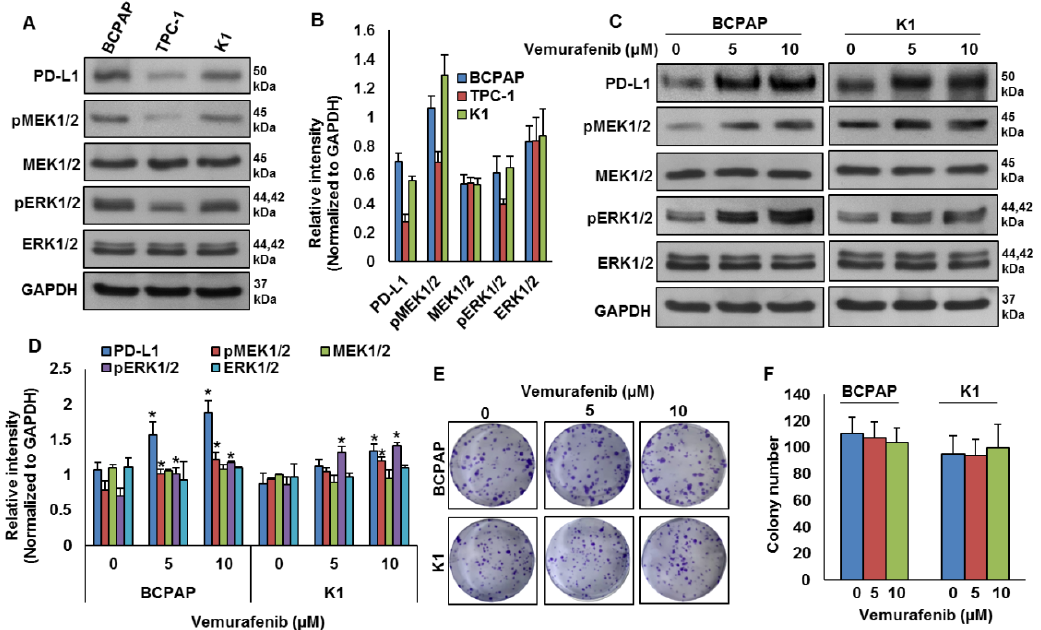
Figure 3. BRAF mutation and its association with PD-L1 in PTC in vitro. ( A , B ) Basal expression of PD-L1 in PTC cell lines. Proteins were isolated from three PTC cell lines and immuno-blotted with antibodies against PD-L1, pMEK1/2, MEK1/2, pERK1/2, ERK1/2 and GAPDH. Western blots were quantified and data are presented as mean ± SD of three independent experiments ( n = 3). ( C , D ) BRAF inhibition increases PD-L1 expression. BRAF -mutated PTC cell lines were treated with indicated doses of vemurafenib for 48 h. After cell lysis, equal amounts of proteins were separated by SDS-PAGE, transferred to immobilon membrane, and immuno-blotted with antibodies against PD-L1, pMEK1/2, MEK1/2, pERK1/2, ERK1/2 and GAPDH as indicated. Western blots were quantified and data are presented as mean ± SD of three independent experiments ( n = 3). * Indicates a statistically significant difference compared to control with p < 0.05. ( E , F ) BRAF inhibition on cell growth. BRAF -mutated PTC cell lines were treated with indicated doses of vemurafenib for 48 h. Cells (5 × 10 2 ) were then re-seeded into a 6-well plate, and grown for an additional 6–8 days, then stained with crystal violet and colonies were counted. Data presented in the bar graphs are the mean ± SD of three independent experiments ( n = 3) which were repeated at least two times with the same results. * Indicates a statistically significant difference compared to control with p < 0.05.